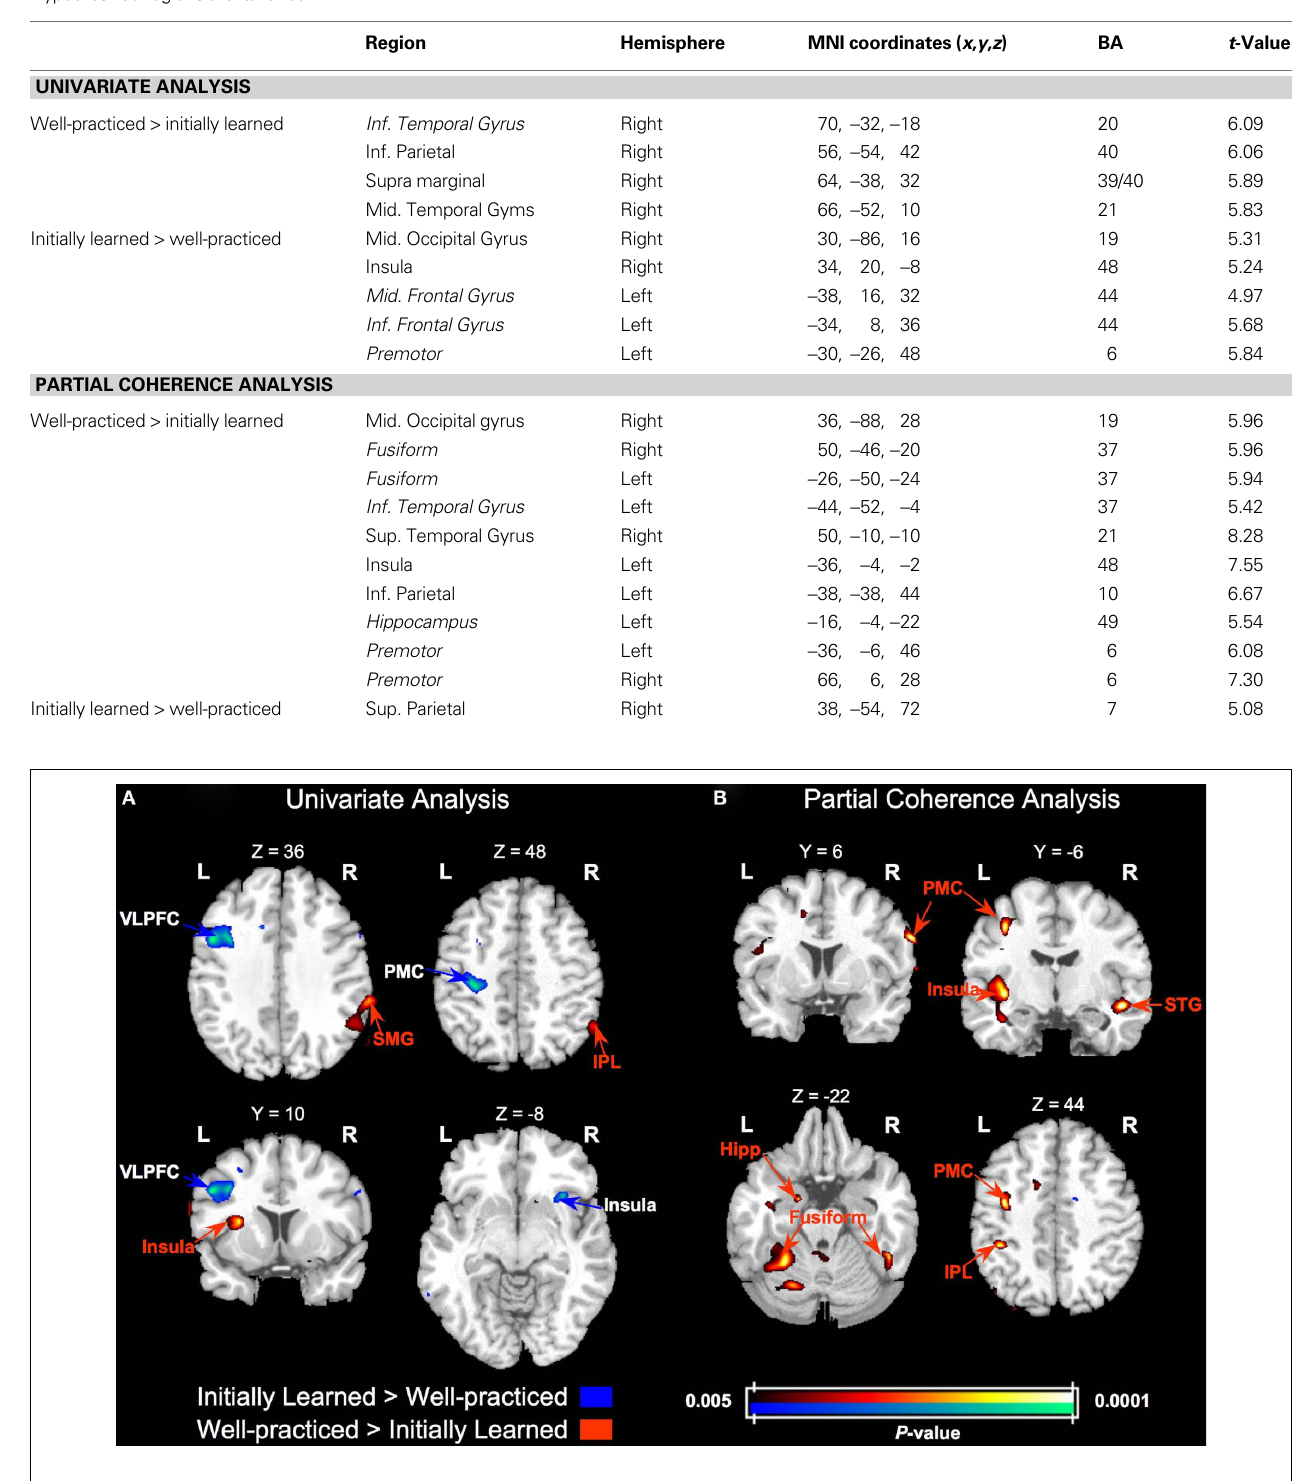
right FFA in the initially learned task and well-practiced task blocks. T maps are overlaid on a standard T1-weighted anatomical image. VLPFC – ventrolateral